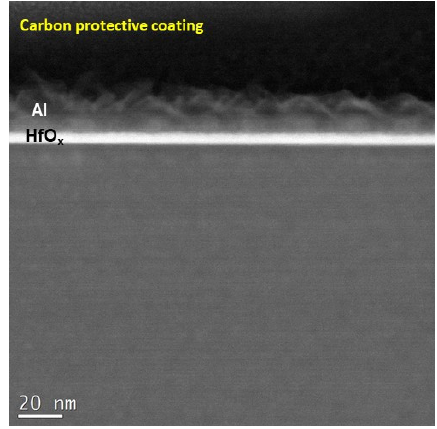
Figure 2. The cross-section (HR-TEM, Z-contrast) of Al / HfO x stack fabricated on a silicon substrate using a pulsed-DC magnetron sputtering process.